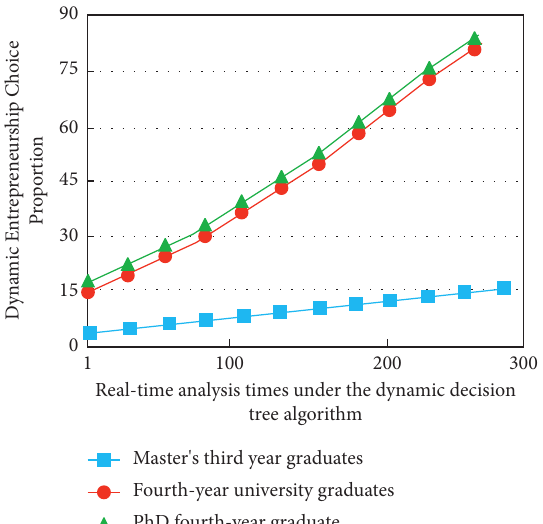
Figure 4: Dynamic simulation analysis of graduates’ choice of entrepreneurship based on dynamic decision tree algorithm.